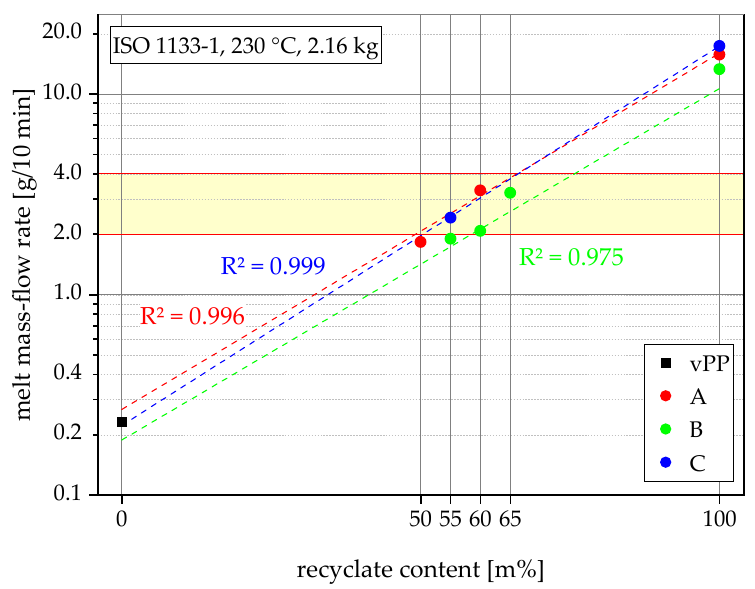
Figure 1. Graphical illustration of the MFR values of all materials.